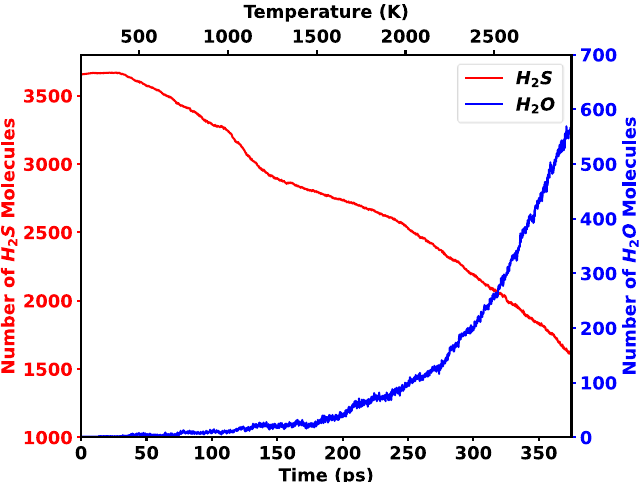
Figure 1. Reduction of H 2 S molecule and formation of H 2 O molecule up to 375 ps in the vacuum. 1968 molecules of H 2 S were reduced and 571 molecules of H 2 O were formed after 375